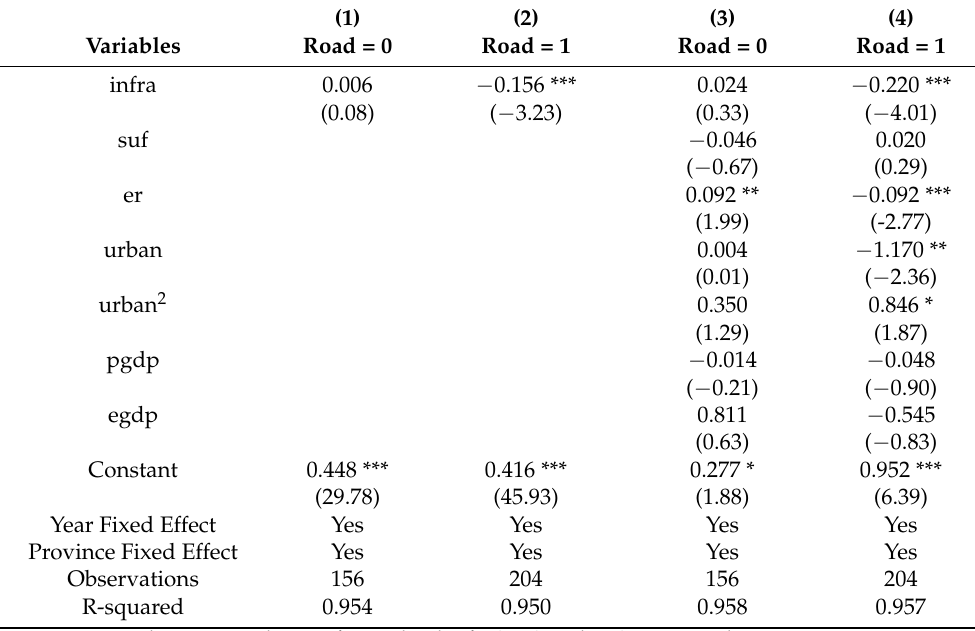
Table 8. Impact of NDI on energy transition in regions with or without in energy